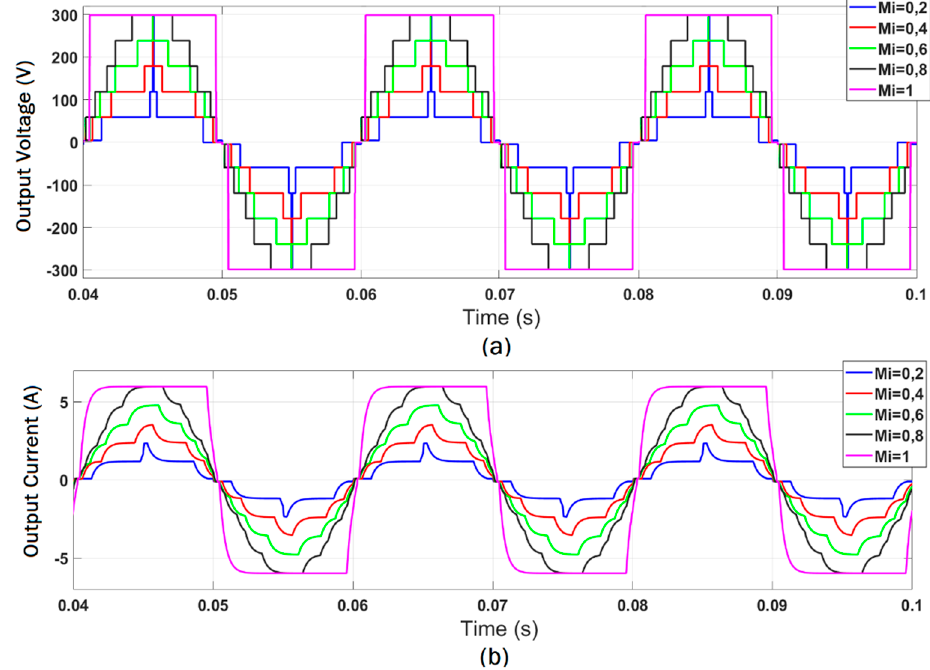
Figure 9. The effect of modulation index variations on the output currents and voltages of 11-level MLI employing the GA method.